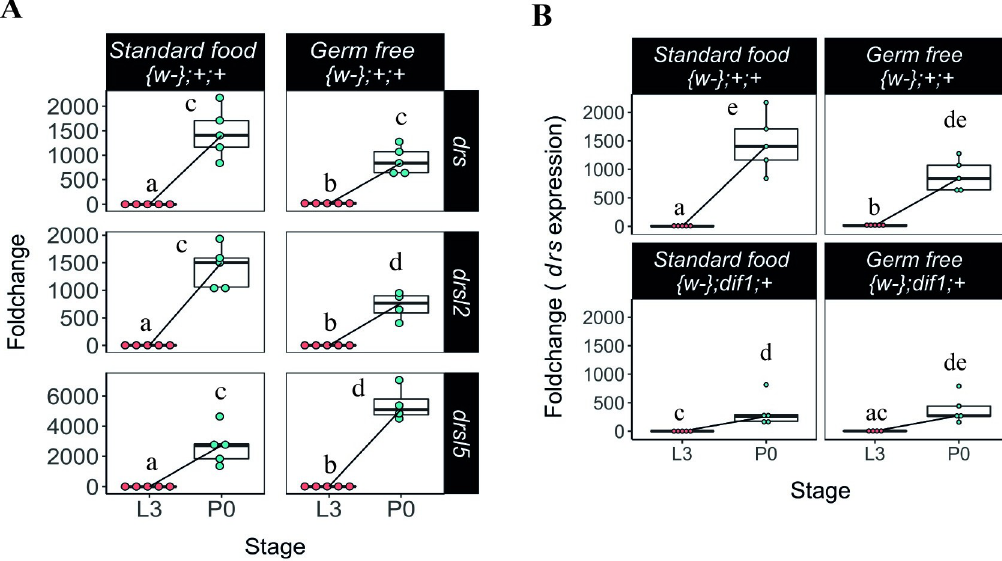
Fig 2. Expression of drs , drsl2 and drsl5 peaks at pupariation regardless of bacterial presence. (A) The expression levels of drosomycin (drs) , drosomycin-like 2 (drsl2) and drosomycin-like 5 (drsl5) increase at pupariation (drs (lsmean , pairwise~{w-};+;+ | Stage � drs < 0 . 0001) , drsl2 (lsmeans(pairwise~{w};+;+|Stage � drsl2 < 0 . 0001)) and drsl5 (lsmeans(pairwise~{w-};+;+| Stage � drsl5 < 0 . 0001)) and are not lost under GF conditions ( lsmeans(pairwise~{w};+;+|Stage � drs < 0 . 0001); lsmeans(pairwise~{w- }; +;+|Stage � drsl2 < 0 . 0001); lsmeans(pairwise~{w};+;+|Stage � drsl5 < 0.0001)) (see also S2 Table and S1 Fig). L3 refers to larvae 24 hours after L3 moult and P0 are white pre-pupae (motionless white pre-pupae with evaginated anterior spiracles). Foldchange was determined using the ΔΔ CT method. Different letters represent statistically significant differences in foldchange. (B) drs expression at pupariation is not dependent on the expression of the NF- κ B factor, dif , both in standard— (lsmeans , pairwise~Stage | +;+;+) < 0 . 0001) , and germ free— (lsmeans , pairwise~Stage | +;+;+) < 0 . 0001) (See also S3 Table). Each dot represents a sample of five pooled individuals; the lines connect the median of the samples at L3 and P0; different letters represent statistically significant differences in fold-change. Fold-change was determined using the ΔΔ CT